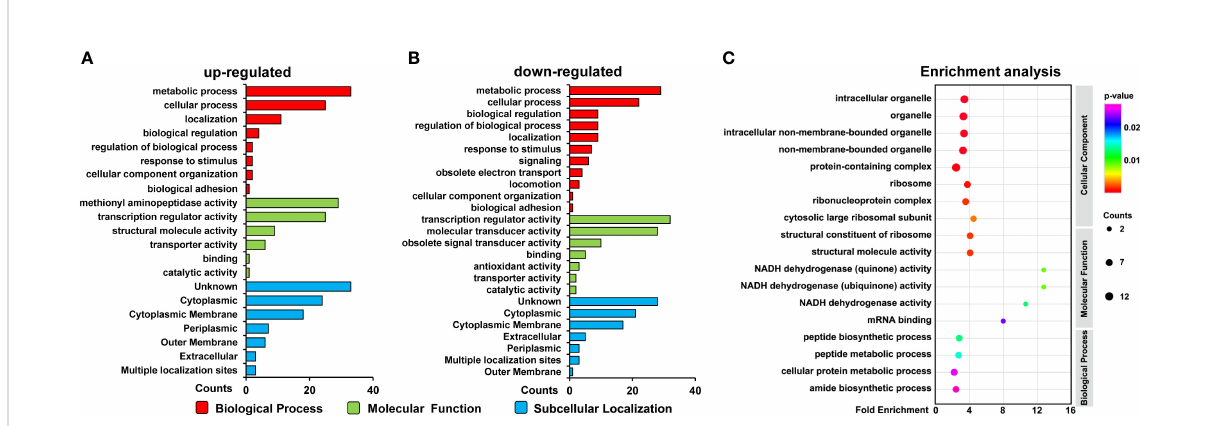
FIGURE 4 Functional analysis of differentially expressed proteins (DEPs). (A) GO classi fi cation of the upregulated proteins and (B) downregulated proteins. (C) GO enrichment of the DEPs. Circle size indicates the number of enriched proteins. Color saturation represents the signi fi cance